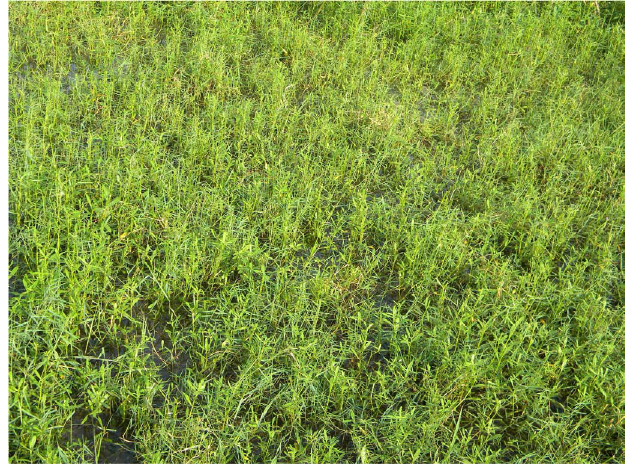
Figure 3. Alternanthera sessilis grows luxuriantly on shores of the lakes.